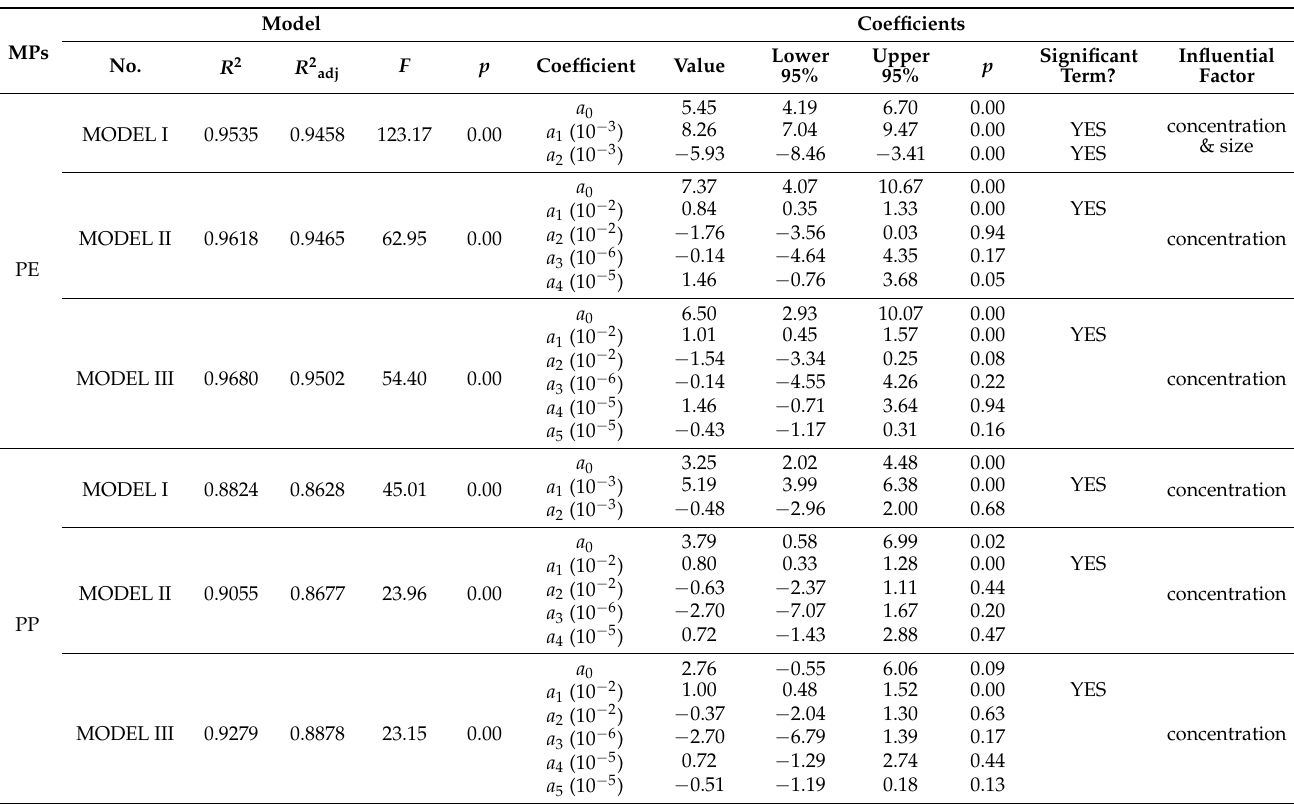
Table 2. Statistical analysis of the regression models (Equations (3)–(5)) for the microalgae Scenedesmus sp. The microalgae were exposed to microplastics (MPs) particles of: polyethylene (PE), polypropylene (PP), polystyrene (PS), polyvinyl chloride (PVC), and polyethylene terephthalate (PET). The analyzed factors were concentration and size of the